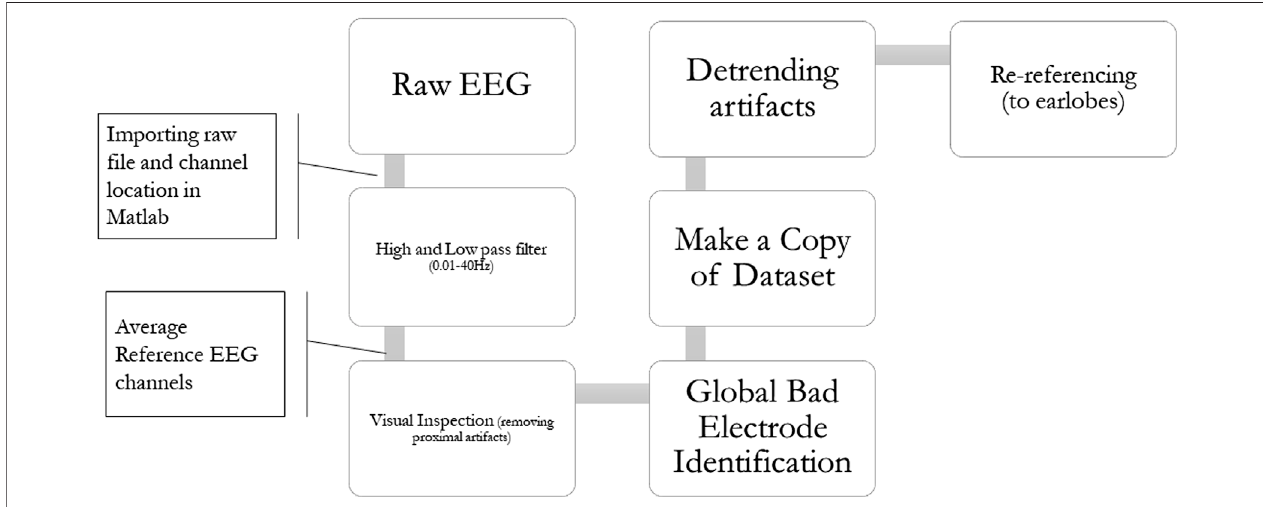
FIGURE3| EEGdatapreprocessingpipeline.1)EEGsignalwillbebandpass fi lteredbetween0.01and40Hz.2)Visualinspectionwillremoveeyemovementsand muscle artifacts. 3) Bad channels (sensors with unusable signals for the process) will be marked. 4) Data will be detrended. 5) and the signal will be re-referenced to the earlobe